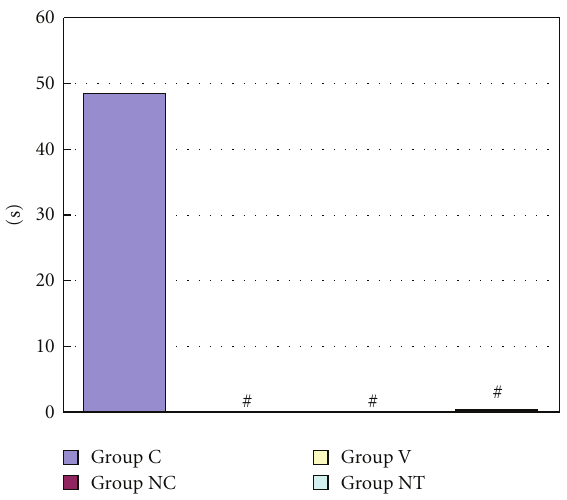
Figure 7: The figure shows duration of arrhythmias during reper- fusion. Group C: a control group. Group NC: a nicardipine group. Group V: a verapamil group. Group NT: a nitroglycerin group. # Significantly di ff erent ( P < . 05) from Group C (mean ±